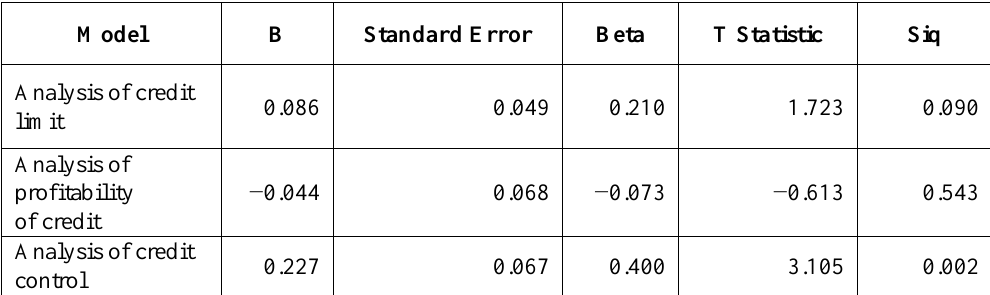
Table 5. Importance of risk in assets management [table and calculations made by